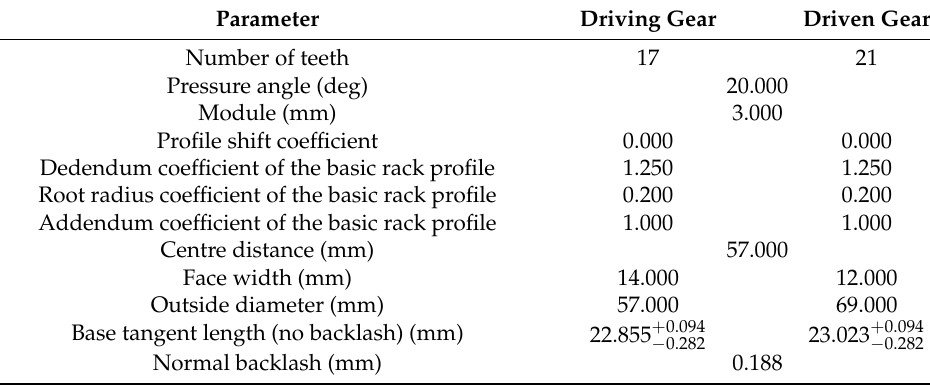
Table 1. Parameters of gears used in test